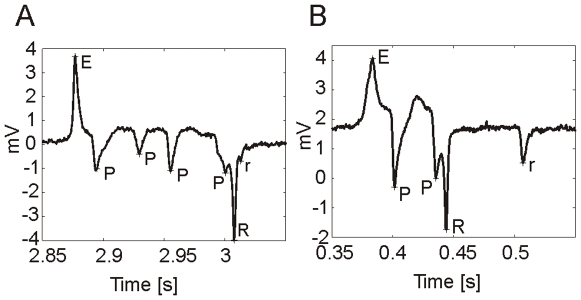
Two EPG pumps recording from wild-type, N2, showing the different temporal positioning of the ‘r’ spike within the EPG waveform.A. In this example the temporal distance between the R and r spike is small, thus the r spike is not distinct but instead appears as a small deflection upon the rising slope of the R-spike. B. In this example the temporal distance between R and r spikes is greater and so the r spike appears completely detached from the R spike.